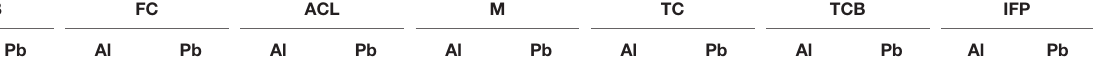
TABLE 5 | Spearman’s correlation coefficients between Al and Pb in the analyzed structures of knee joint.